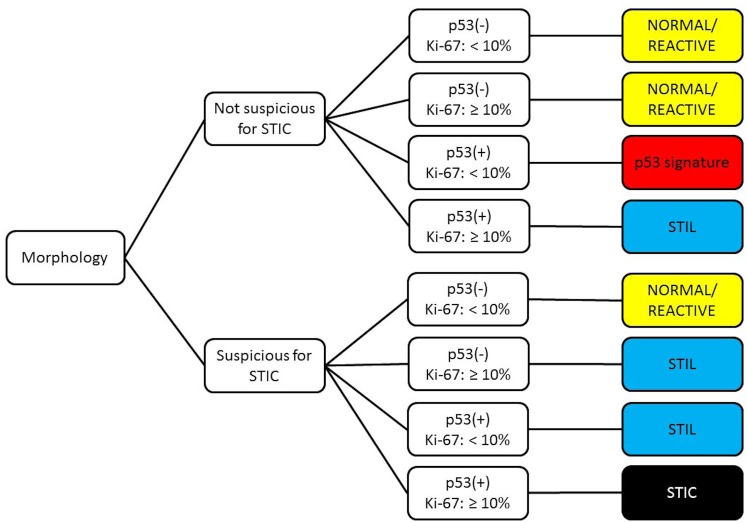
The diagnostic algorithm of tubal epithelial lesions with p53 alterations.[16,17].STIC; serous tubal intraepithelial carcinoma, STIL; serous tubal intraepithelial lesion.